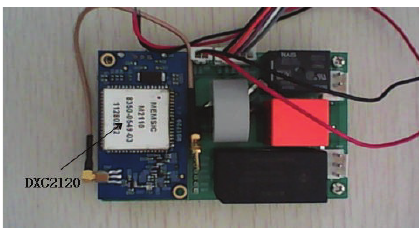
Figure 10: Circuits of the sensor node.